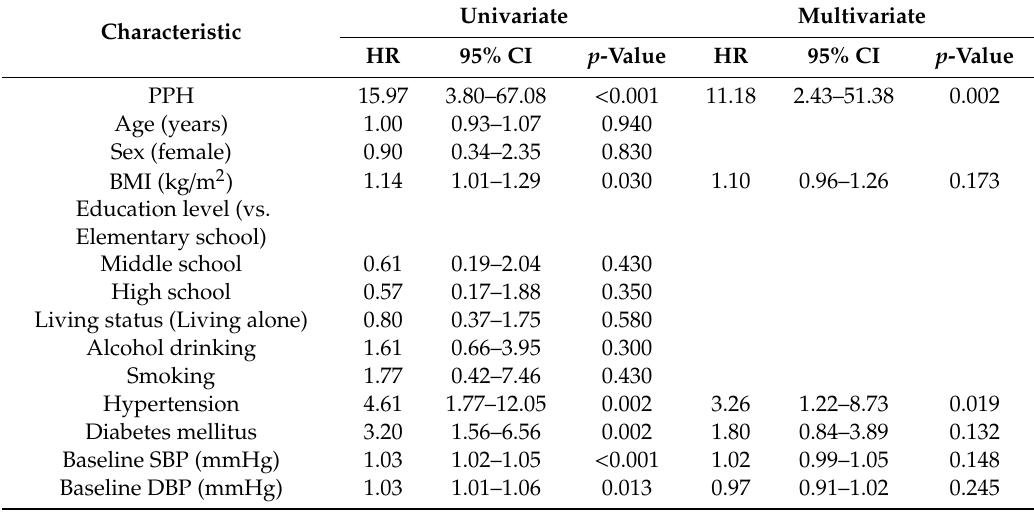
Table 3. Summary of time-dependent Cox regression analyses using time-varying covariates (a total of 94 subjects, 30